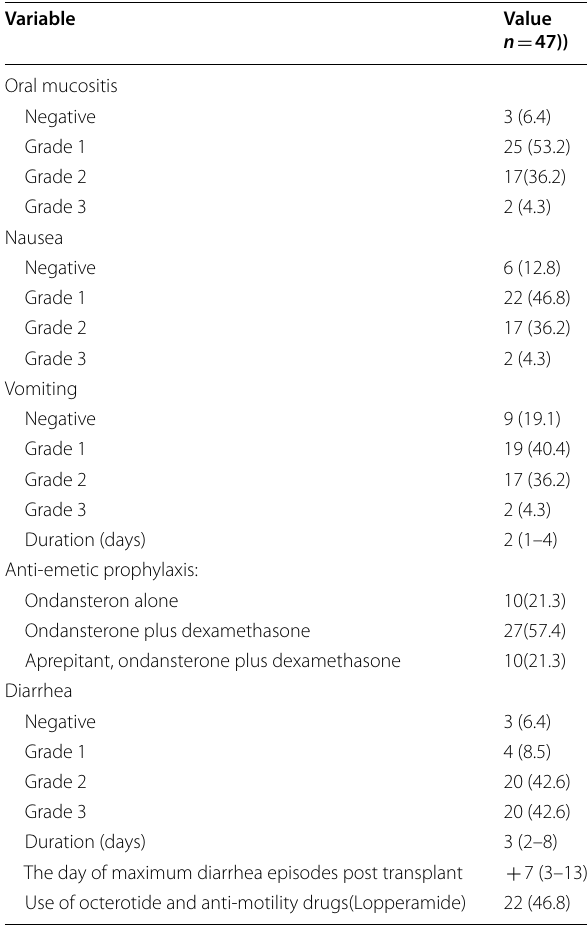
Table 2 Incidence of GI toxicities among